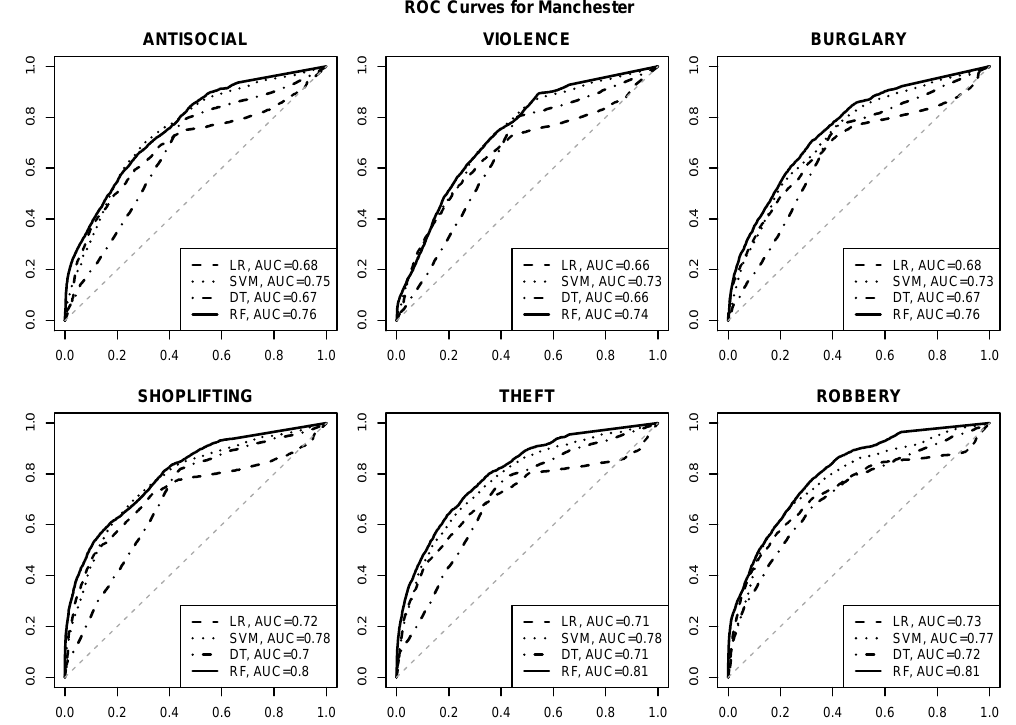
Figure 6. The ROC curves for crime risk prediction in Manchester.